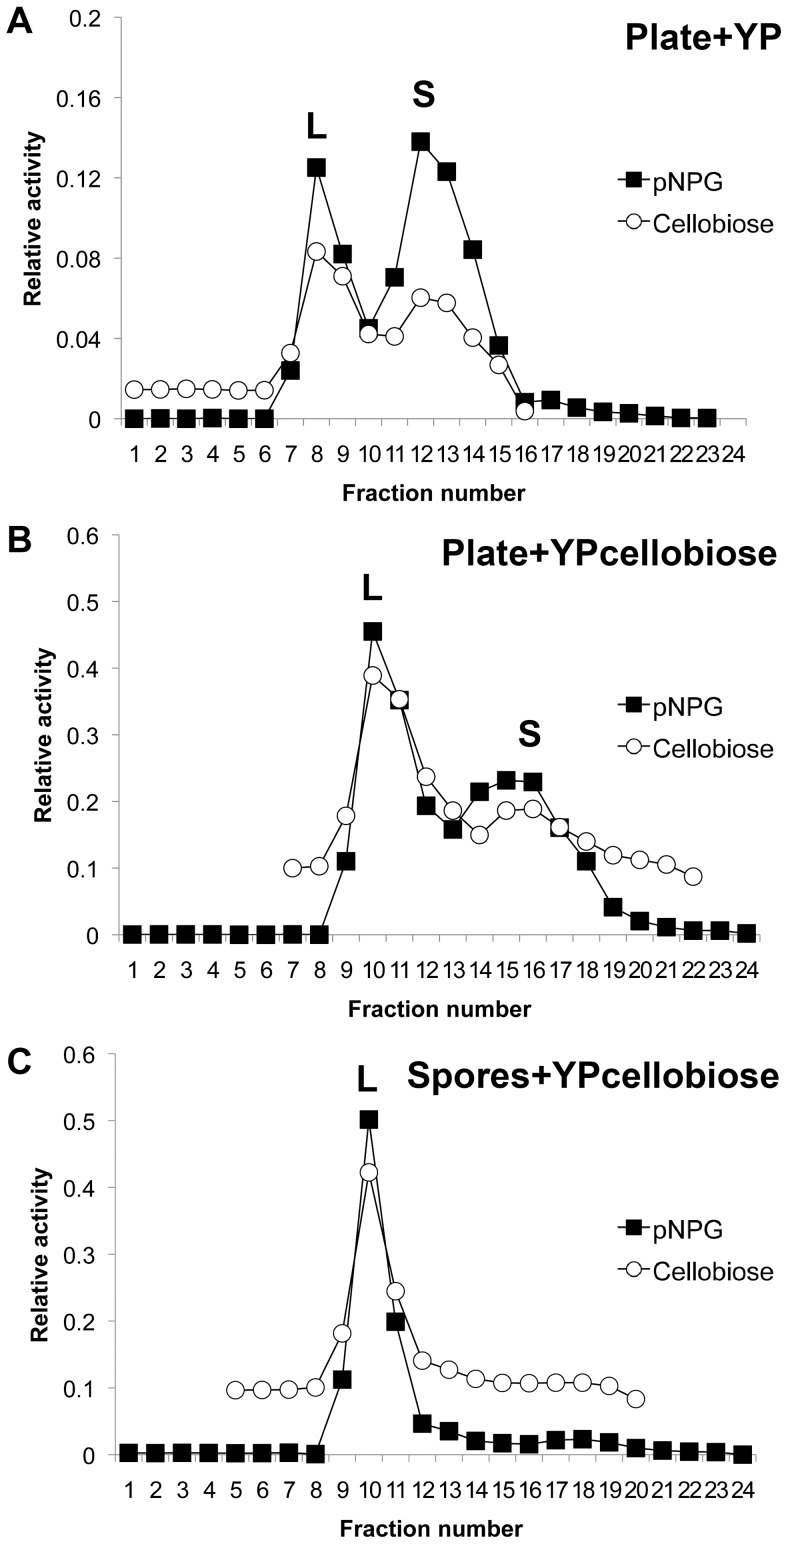

C. raphigera produces two variants of β—glucosidase that can be separated by size exclusion chromatography.The peak of activity recovered from anion exchange chromatography was concentrated and resolved by size exclusion chromatography. BGL activity of the fractions was monitored using pNPG (closed squares) and cellobiose assays (open circles). Two peaks, large (L) and small (S) were identified in varying amounts depending on fungal growth conditions. (A) Sephadex G200 fractions analyzed by pNPG and cellobiose assays from 3-day old YP liquid culture with 14-day old C. raphigera on potato dextrose agar with agar also transferred into the liquid medium. (B) From 3-day old YP liquid medium with 10 mM cellobiose with 14-day old C. raphigera on potato dextrose agar. (C) From YP liquid medium with 10 mM cellobiose inoculated with spores scraped from a 14-day old C. raphigera plate. Results were representative of three independent studies.